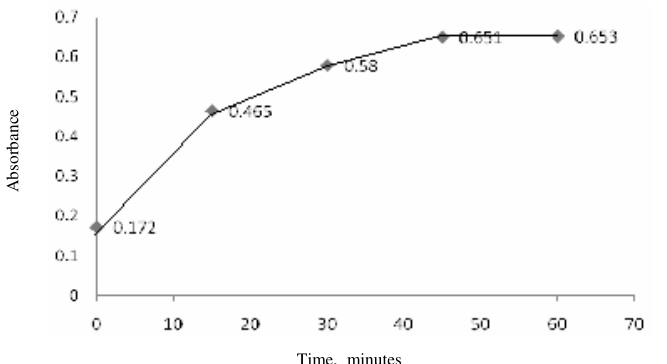
Figure 4. Absorbance of (cefadroxil-sodium hydroxide product) vs heating time Table 1. Estimation of cefadroxil-NaOH complex reaction time and stability Heating